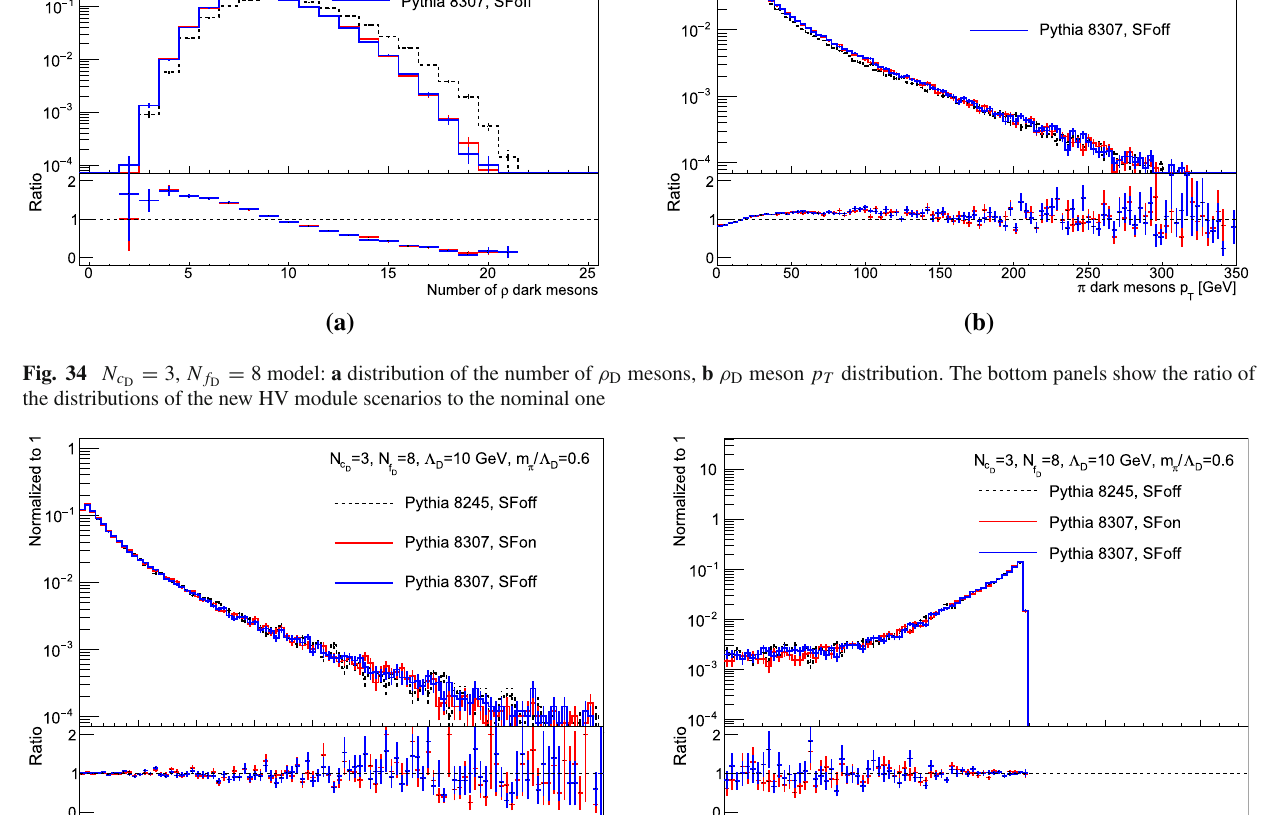
= 3, N = 8 model: a distribution of the generator level missing transverse energy (cid:3) E Fig. 35 N c f D D angle between jets and (cid:3) E T . The bottom panels show the ratio of the distributions of the new HV module scenarios to the nominal